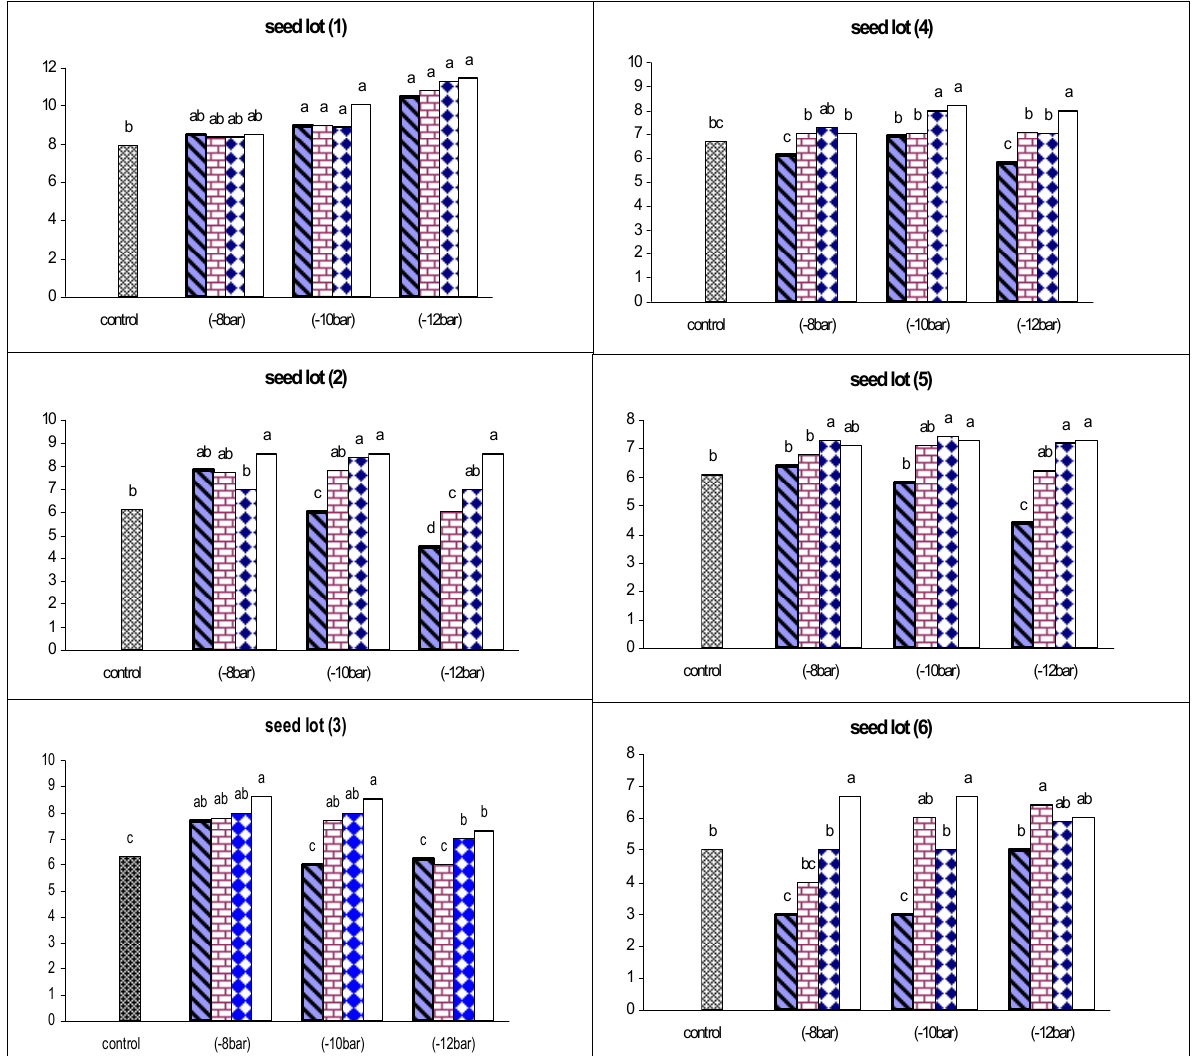
Fig. 5. Influence of osmotic potential levels of osmopriming treatments on the vigor index (VI) in soybean seed lots (cv. ‘Sari’) under 12 , 24 , 36 and 48 hours durations. Horizontal axe shows priming with -8 bar; -10 bar; -12 bar; polyethylene glycol and 0 bar as a control group . Vertical axe is vigor